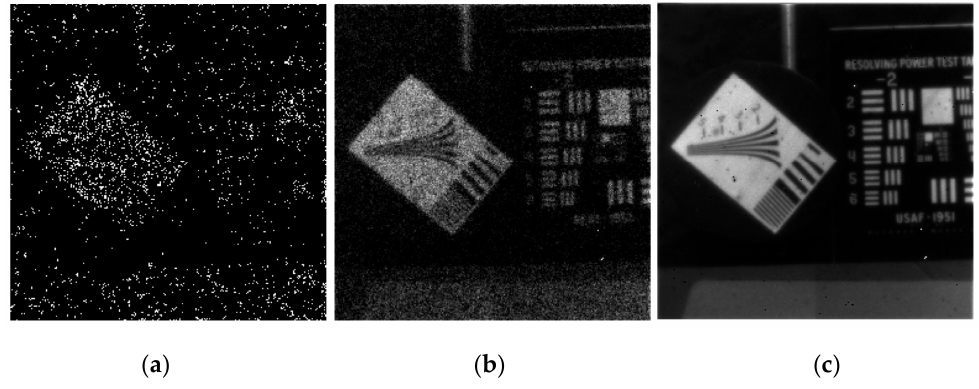
Figure 15. ( a ) One binary frame; ( b ) the digital sum of 64 binary frames; and ( c ) the digital sum of 32,768 binary frames.